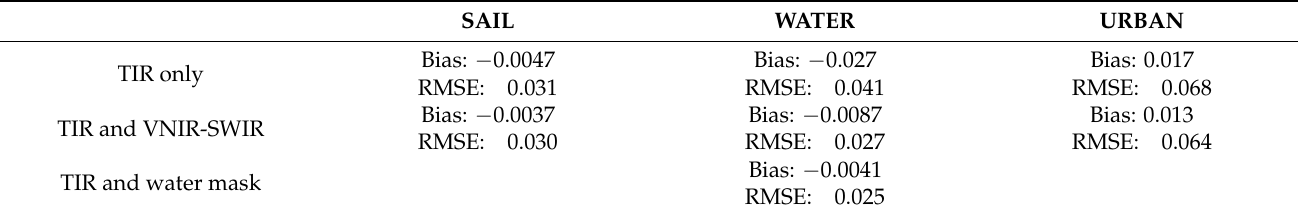
Table 2. Retrieved emissivity errors. SAIL